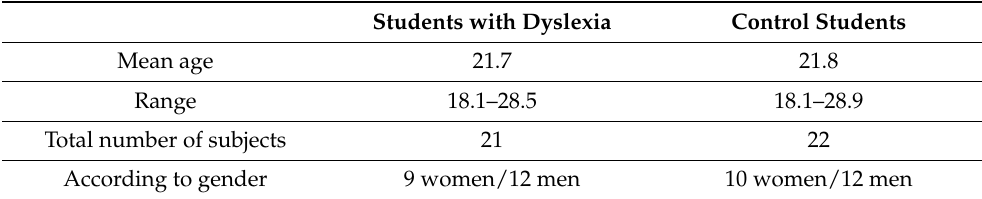
Table 1. Description of participants in the psycholinguistic